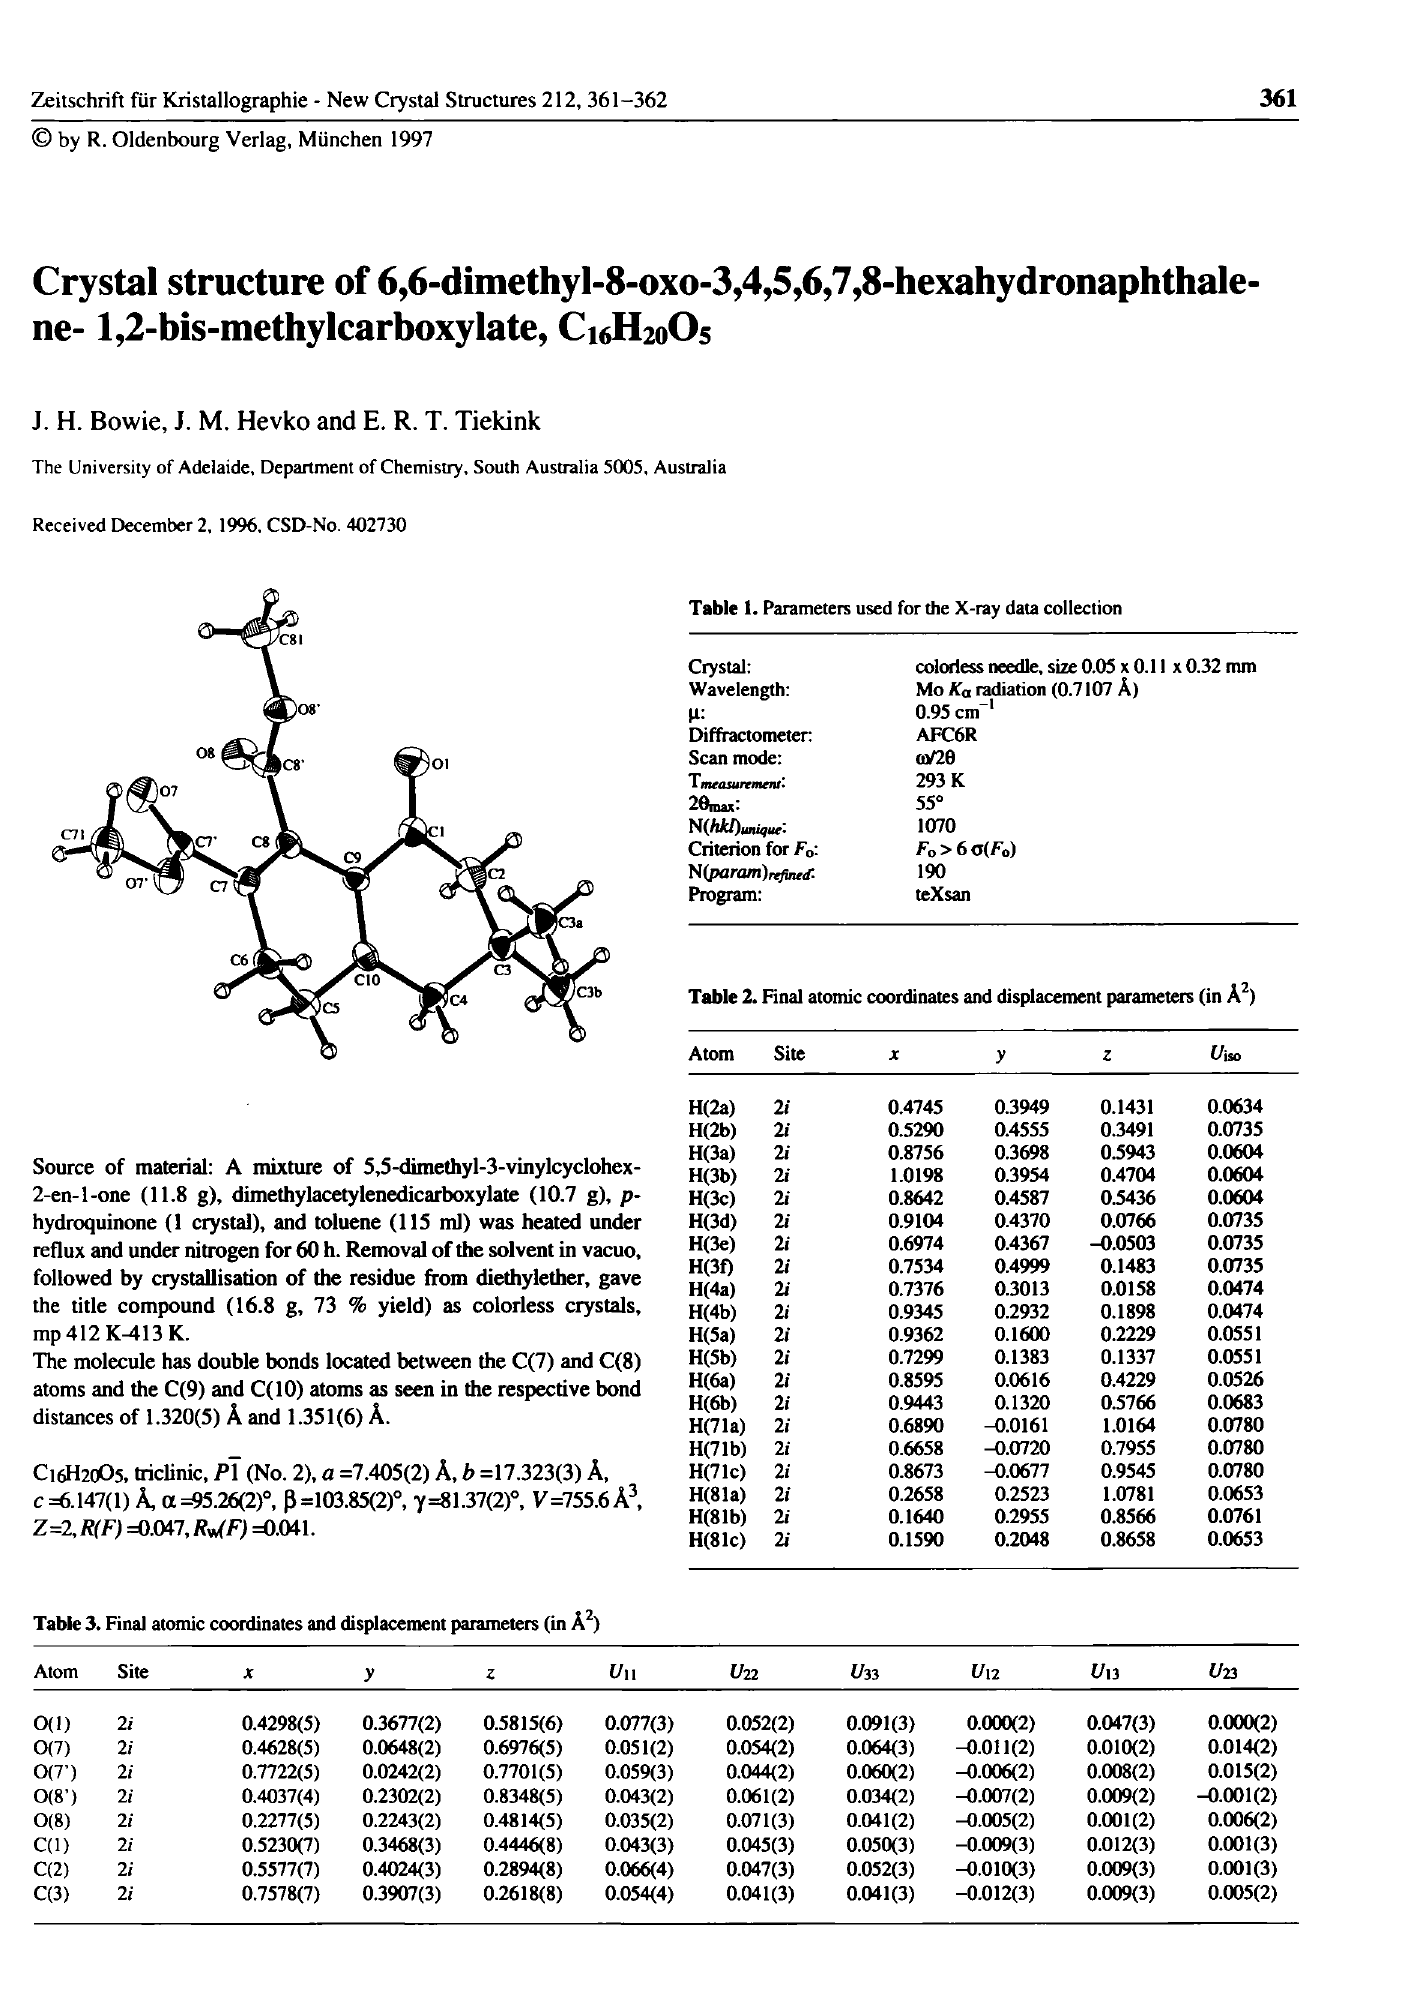
Table 3. Final atomic coordinates and displacement parameters (in Â 2